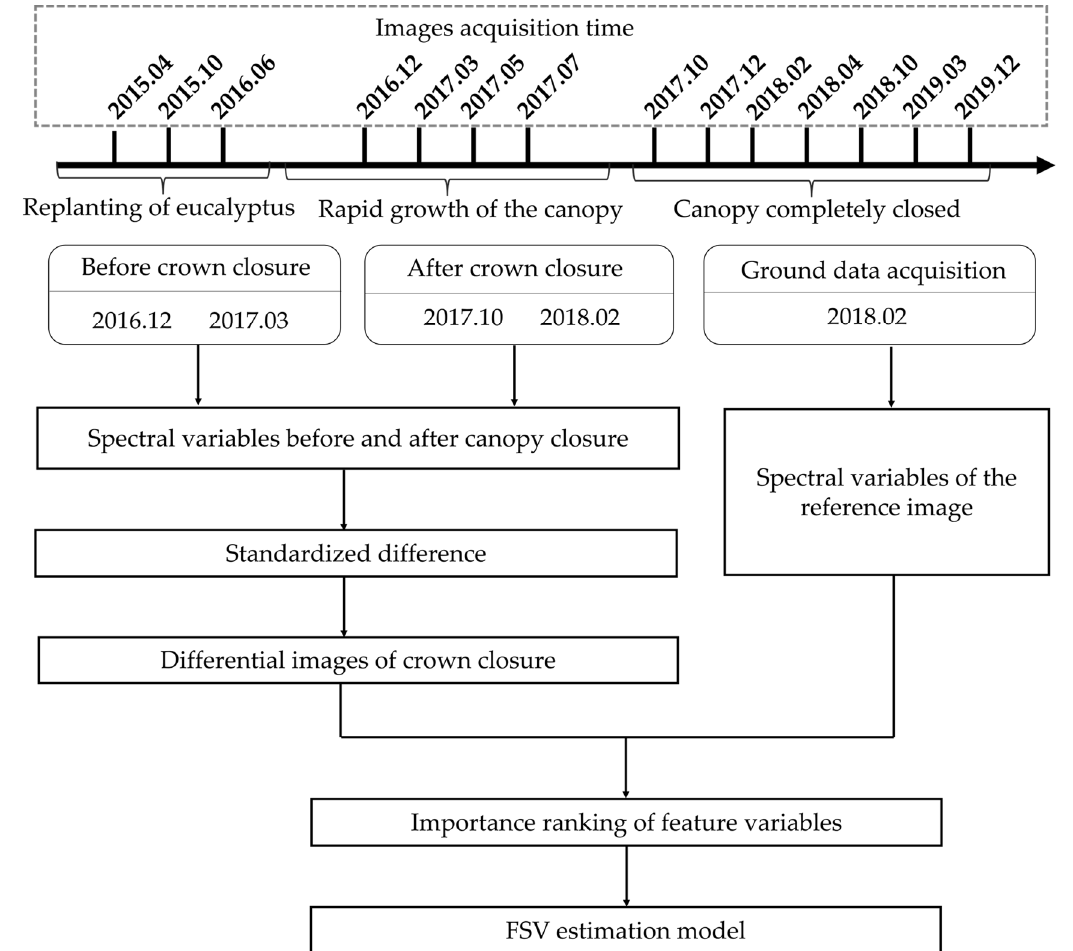
Figure 3. The flowchart of composite LC8